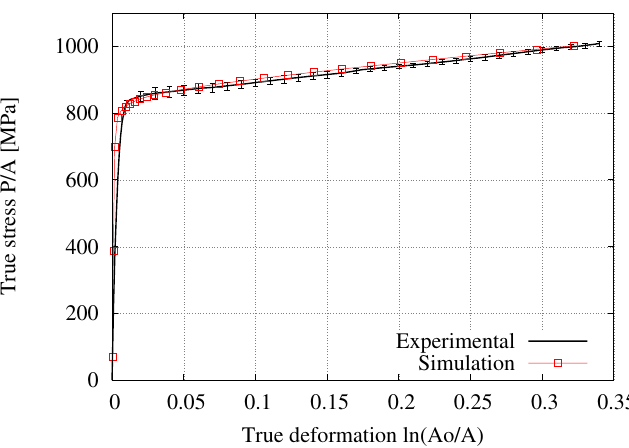
Figure 11. Average experimental and numerical results for the true stress–strain relationship, NRMSD = 0.91%.